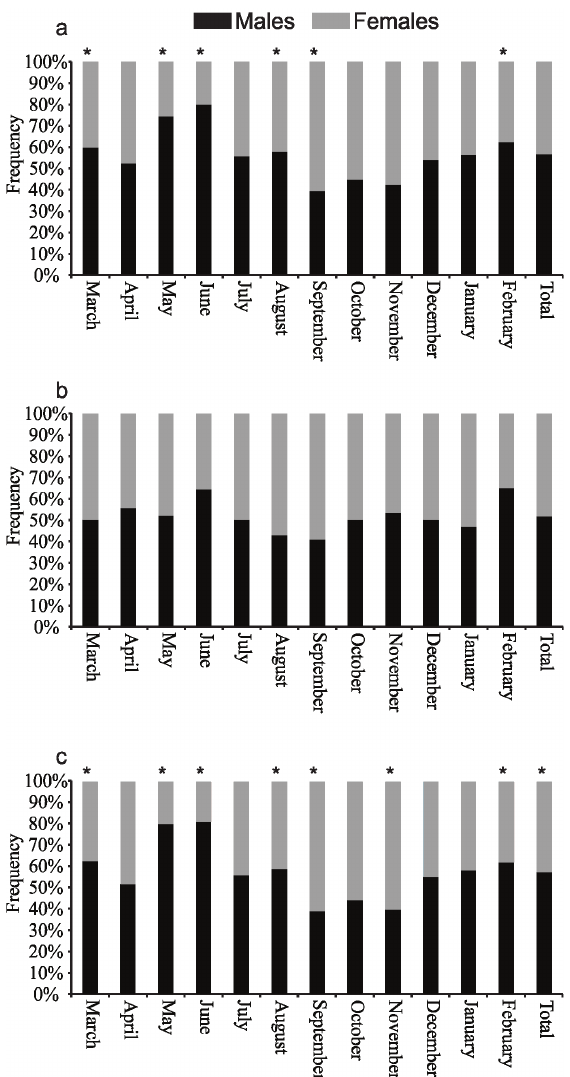
Figure 2. Aegla schmitti : Sex ratio in the Arraial River. a: Combined data. b: Animals sampled with handnets. c: Animals sampled with traps. * = significant difference according to the Chi-squared